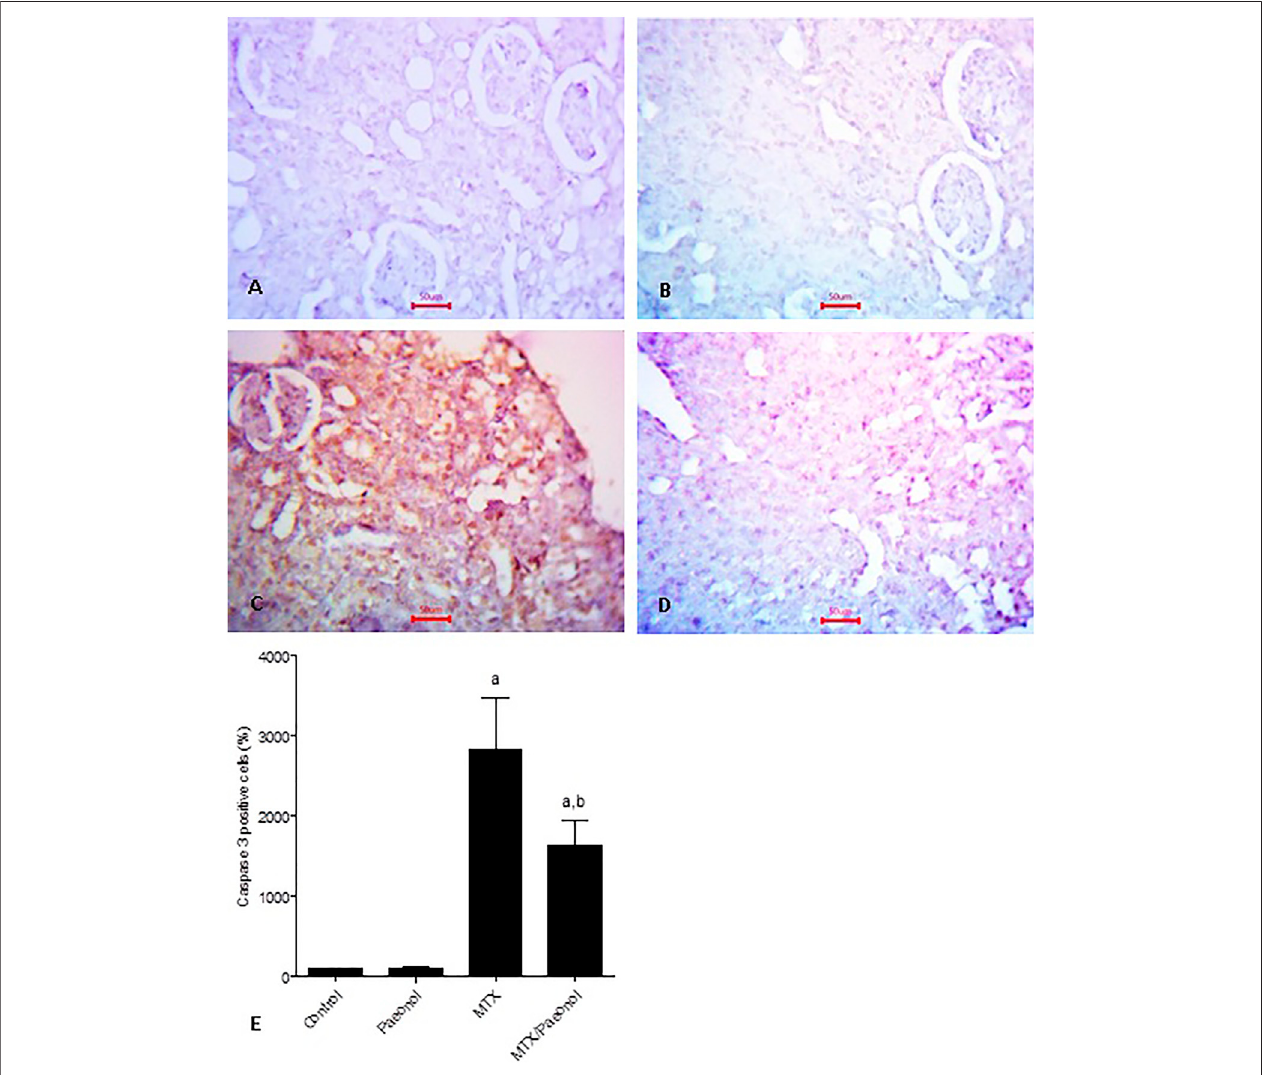
FIGURE6| Caspase3immunohistochemicalstainingofthekidneyaftermethotrexate (MTX)and/or paeonoladministration.Caspase 3antibody-stainedsections of the rat kidney (×400) from (A) control, (B) paeonol-treated, (C) MTX-treated, and (D) MTX/paeonol-treated rats. (E) Percent of positive cells compared to the control group, obtained from sections of each animal ( n = 6 for each group), six fi elds/section, where results were considered signi fi cantly different when p < .05. a,b Signi fi cant difference compared to control or MTX groups, respectively.